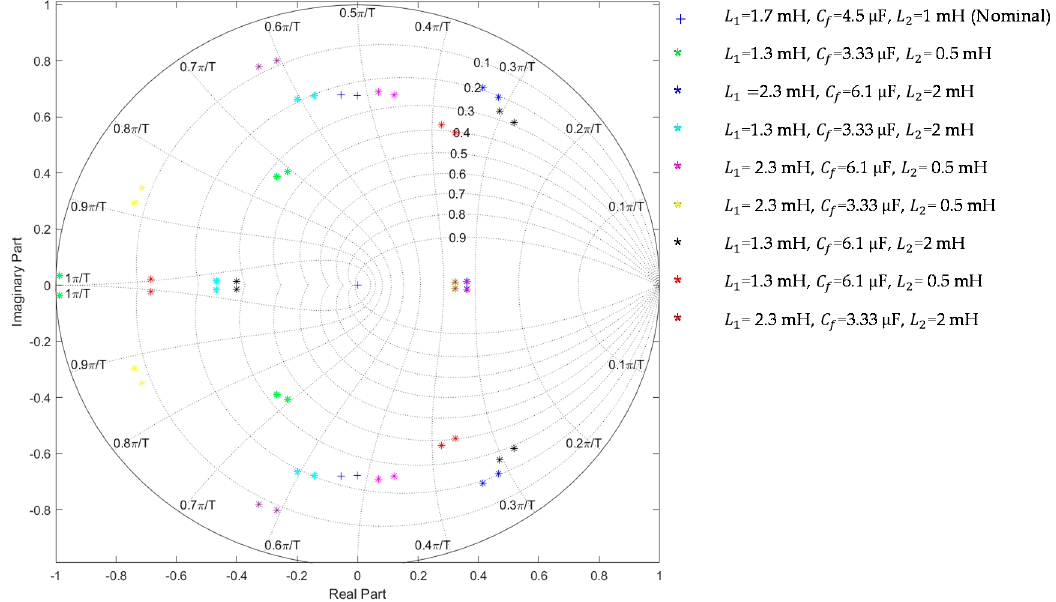
Figure 4. Eigenvalues of the proposed MPC scheme under uncertainties of LCL filter parameters.